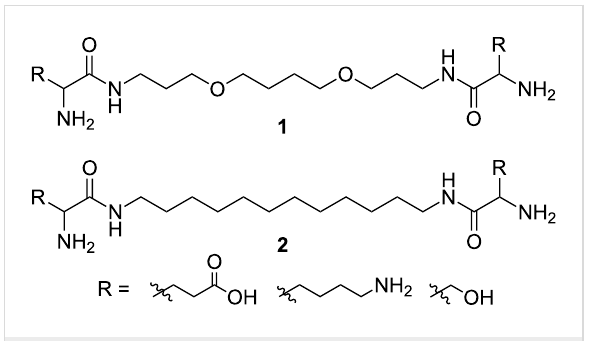
Figure 1: Novel artificial RNases based on amino